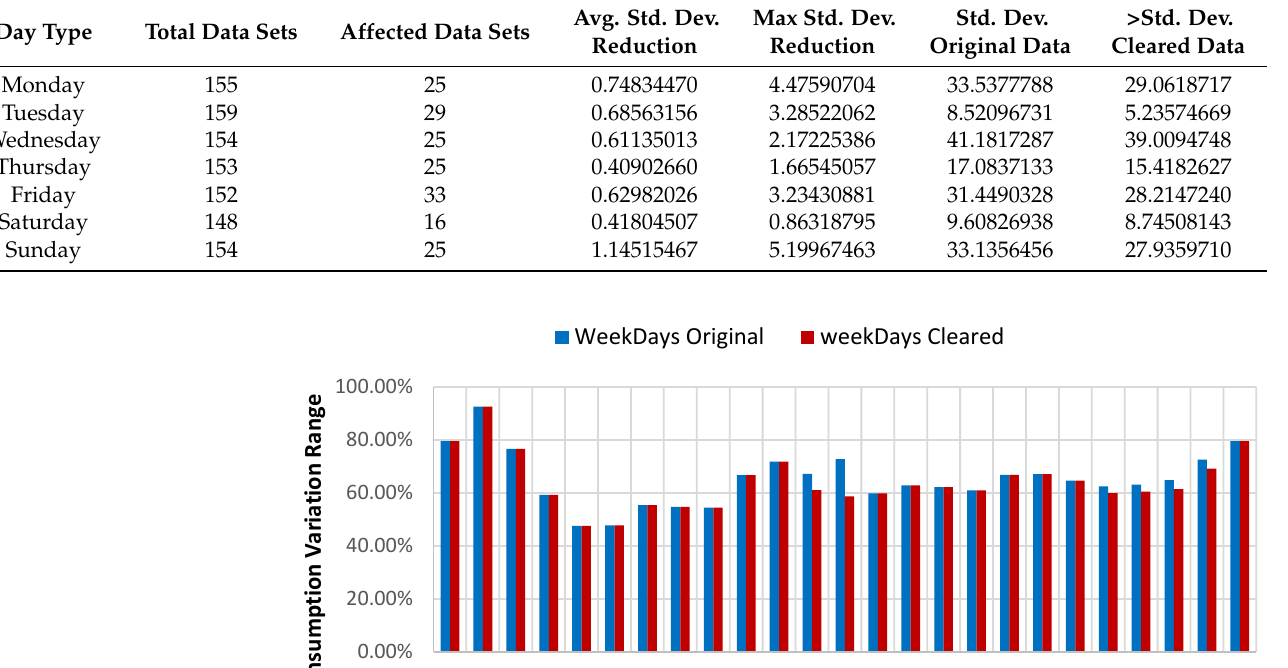
Figure 20. Daily consumption baseline for the original and cleared data sets. 5. Conclusions During the DR-BOB “Demand Response in Blocks of Buildings” project, the energy demand from 12 buildings at four different locations was monitored, 36 Demand Re- sponse events were successfully implemented during an evaluation period of one year. In order to improve the quality of baseline data and key performance indicators (KPI) eval- uation, a data cleaning process was proposed (interquartile range, median absolute devi- ation, local outlier factor, density-based spatial clustering of applications with noise, in- telligent scoring method). The numerical results showcased that even in case of different energy profiles, the cleaned data was reduced in all the cases, the standard deviation of the baseline with an average of 0.41%, which means that the nature of the data is not af- fected by the removal of outliers and we also gain more accuracy in baseline. More than that, this highlights the fact that a cleaning process in data energy, before any qualitative or quantitative process, can significantly improve the quality of the results. It is also im- portant to mention that in addition to the proposed outlier detection techniques a custom